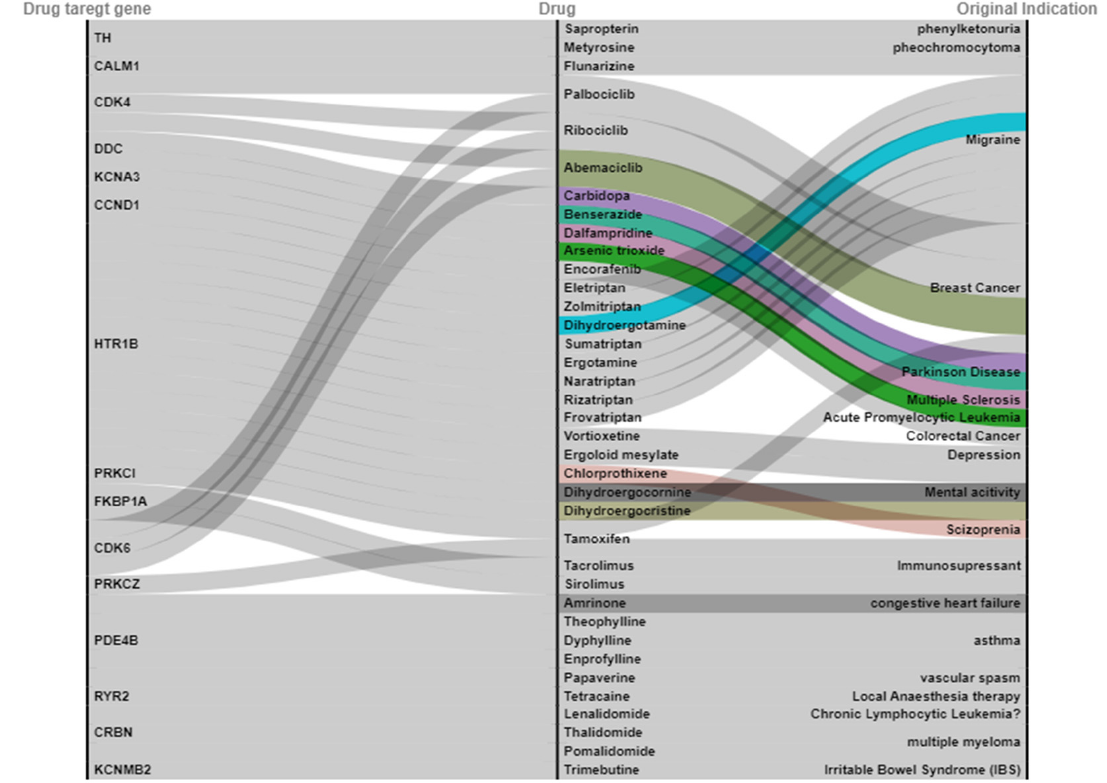
Figure 2. 37 drugs overlapped with 15 candidate drug target genes. Four out of these 15 genes ( DDC , KCNMB2 , PDE4B , and RYR2 ) were included in the list of the previously defined “biological ALL risk genes” (Figure 2). The data visualization in this figure was produced using RAWGraphs visualization (https://app.rawgraphs.io/ accessed on 12 July 2022).